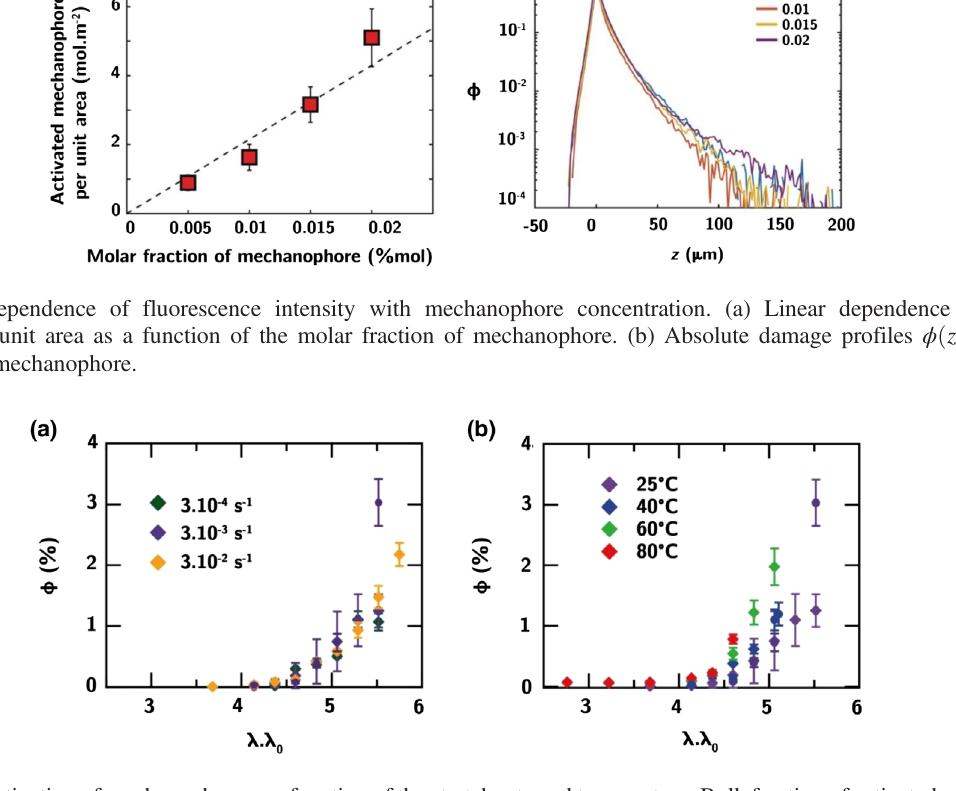
FIG. 9. Intrinsic activation of mechanophore as a function of the stretch rate and temperature. Bulk fraction of activated mechanophore in the triple network, as a function of the stretch λ · λ 0 on the first network for (a) various stretch rates and (b)